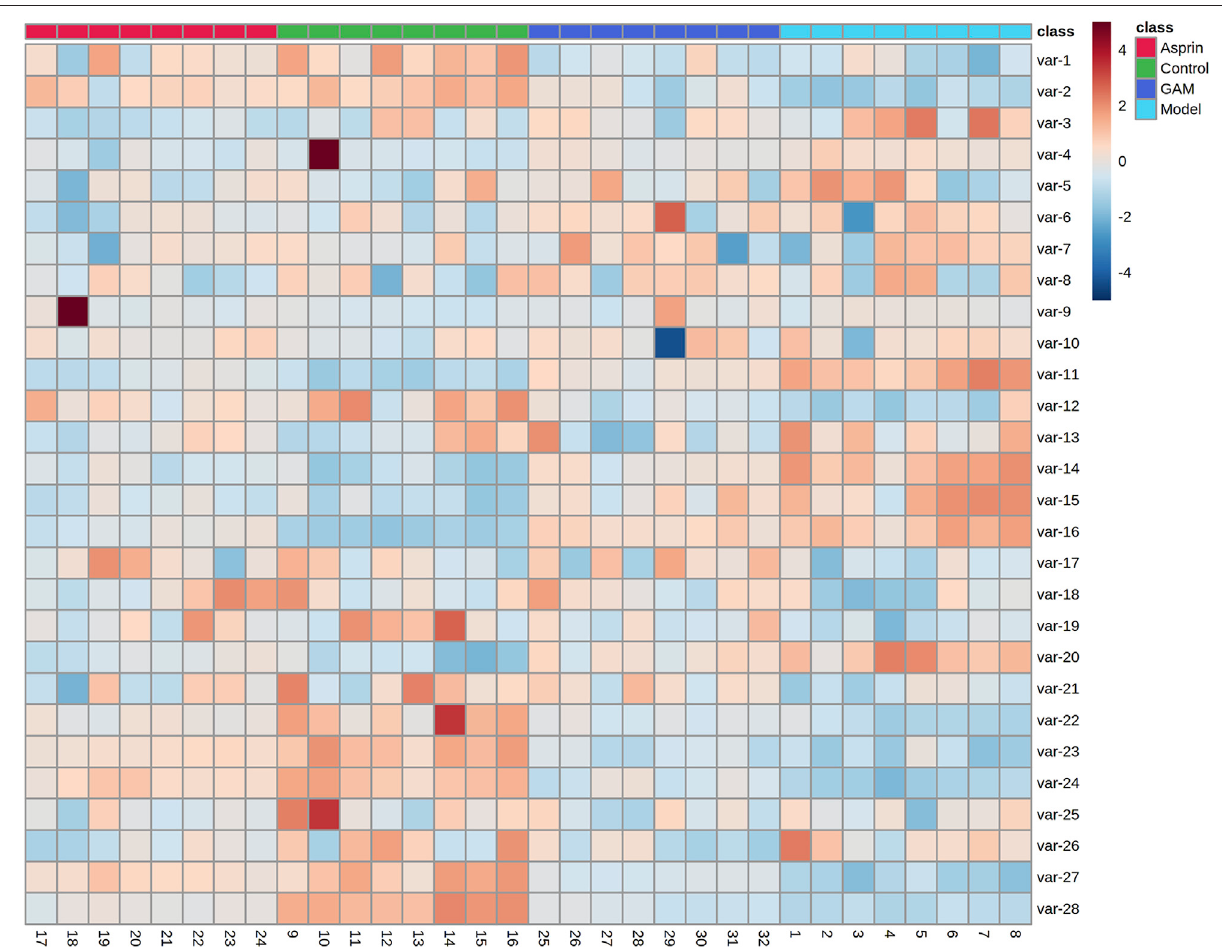
Frontiers in Pharmacology |